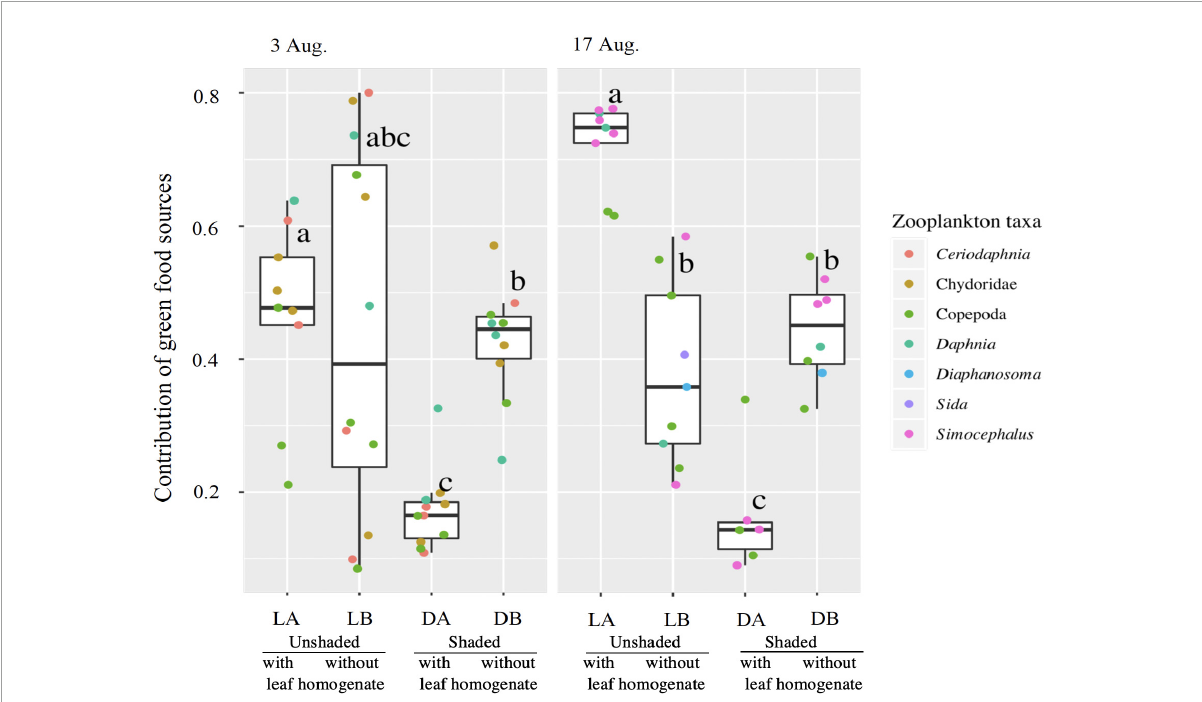
FIGURE5 Contributions of autochthonous sources to zooplankton production. The bold line in the box indicates the median value. The upper and lower limits of the box, and the whisker plots indicate the first and third quartiles, and ± 1.5 × interquartile range, respectively. Significant differences among treatments are denoted by different letters. Points with different colors represent values for different zooplankton